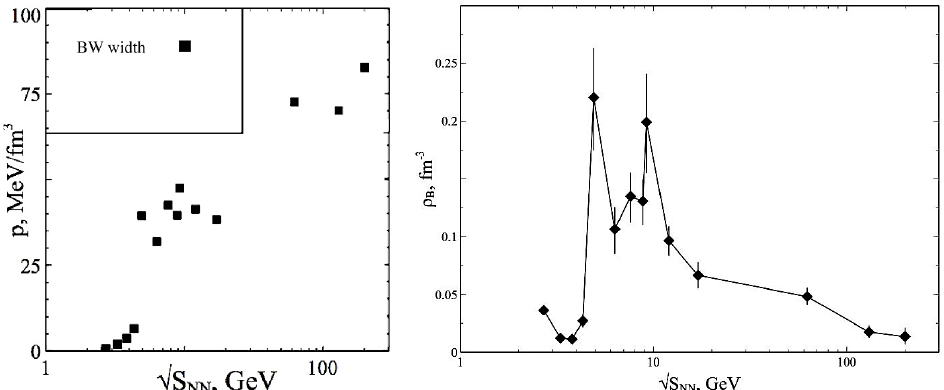
Figure 2. Left panel: Pressure at chemical freeze-out as a function of the collision energy MHRGM2 (squares) [21]. The Breit-Wigner parameterization of the resonance width is used in this model. Right panel: The same as in the left panel, but for the baryonic charge